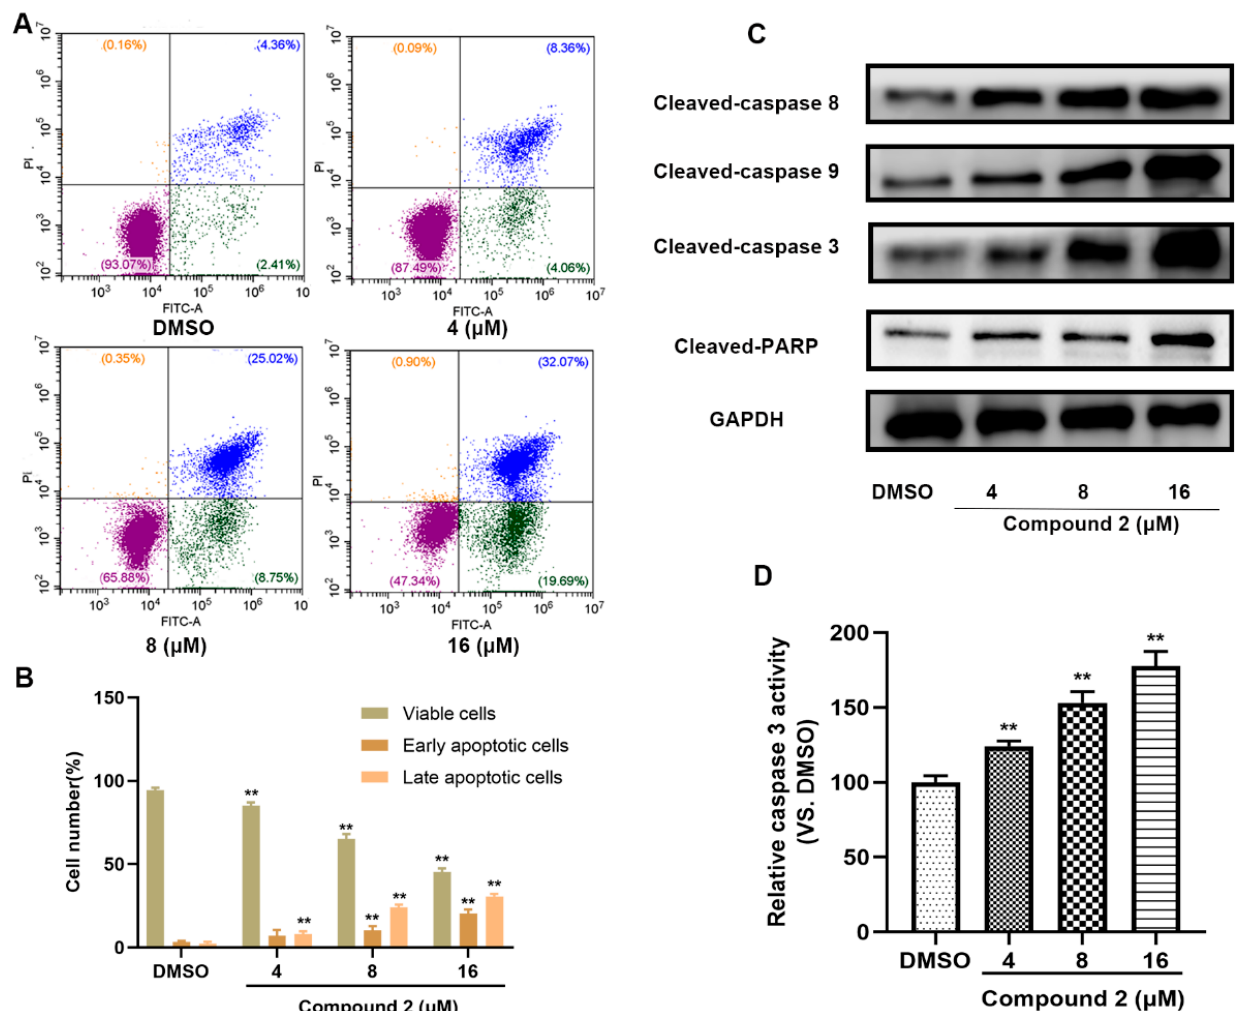
Figure 6. Compound 2 causes A549 cell apoptosis. ( A ) After 72 h of corresponding compound 2 treatment, A549 cells were collected and the apoptotic cell was detected by flow cytometry. ( B ) The percentage of apoptotic cells induced by compound 2 . ( C ) The effects of a 72 h compound 2 treatment on apoptosis-related signaling pathway. ( D ) After compound 2 treatment for 72 h, caspase-3 activity was detected. (**) p < 0.01 compared with the control group. Cont., DMSO control.